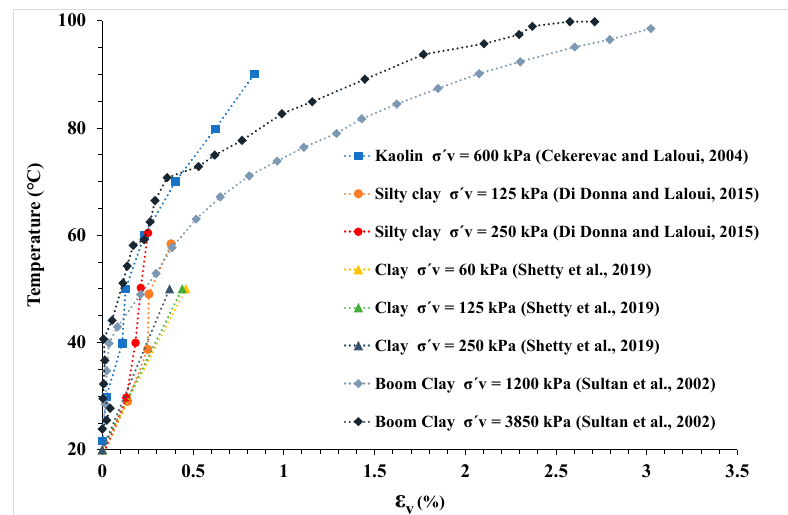
Figure 1. Volumetric change for normally consolidated fine soil.